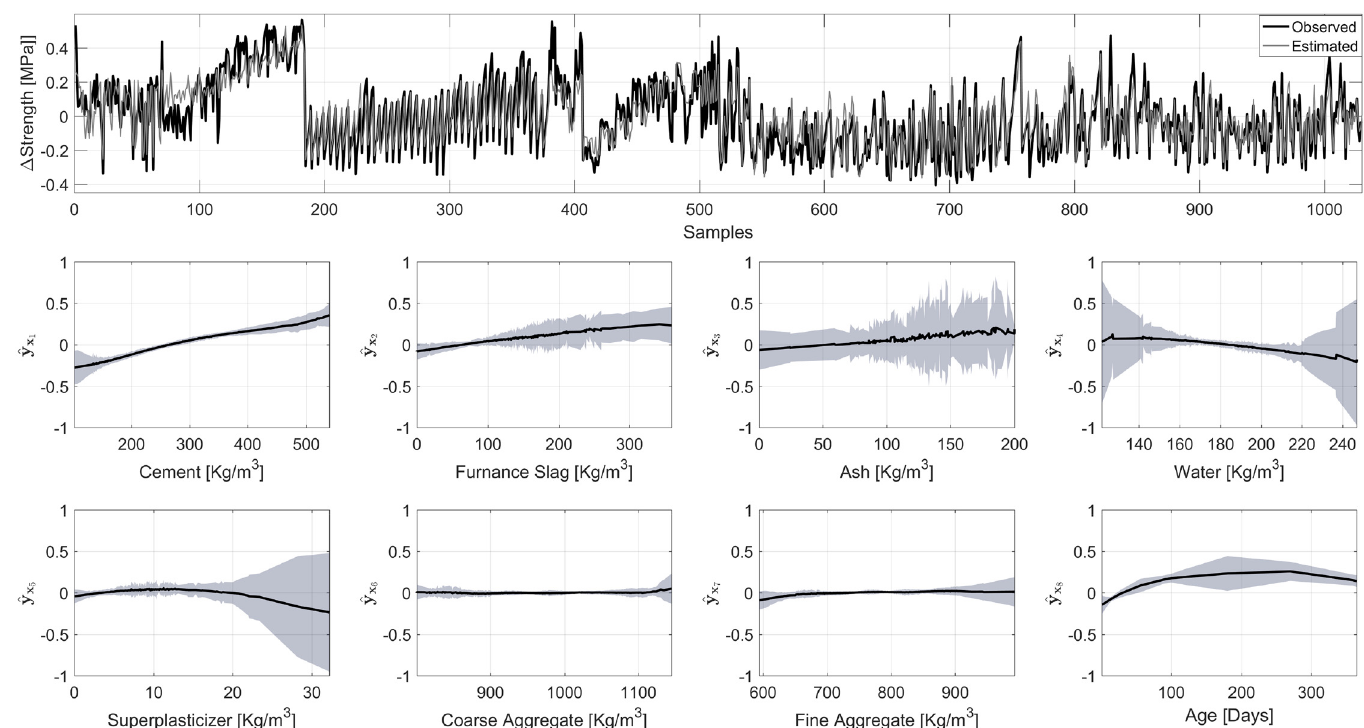
Fig 10. Model fitting, presented in the top plot, and estimation of the functional form of the contribution of the input variables in the concrete strength dataset from the UCI machine learning repository. In the top plot, the black line represents the measured strength of the cement mix, and in gray the estimated value using an LS-SVM model. For the contributions, the gray area represents the 95% confidence interval, obtained using bootstrap, and the solid black line the mean value of the contribution.